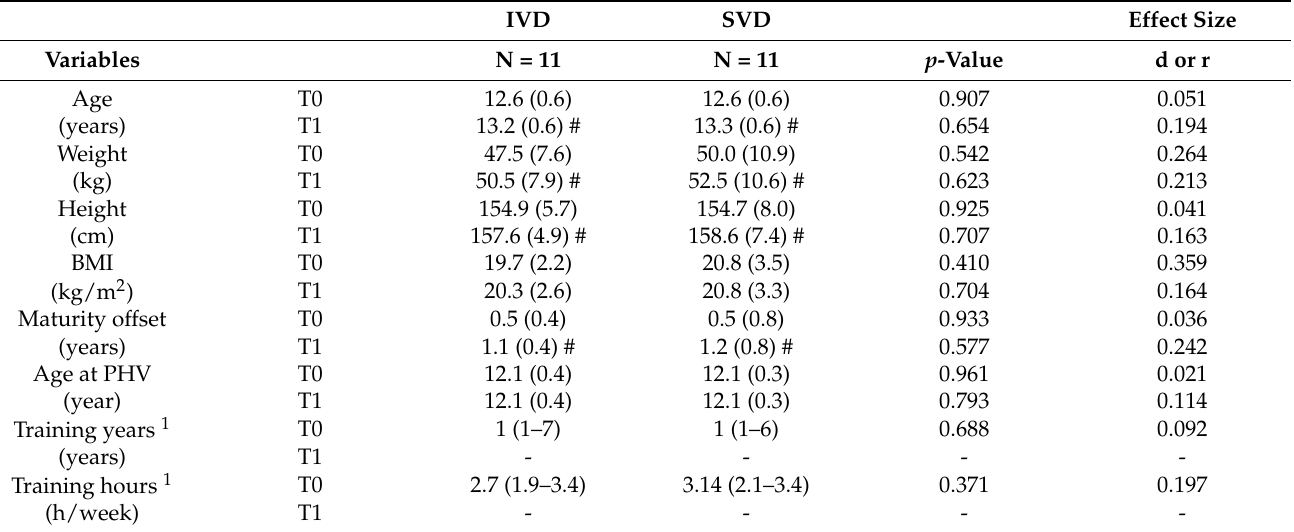
Table 1. Descriptive characteristics of female football players with different 25(OH)D concentrations. IVD SVD Effect